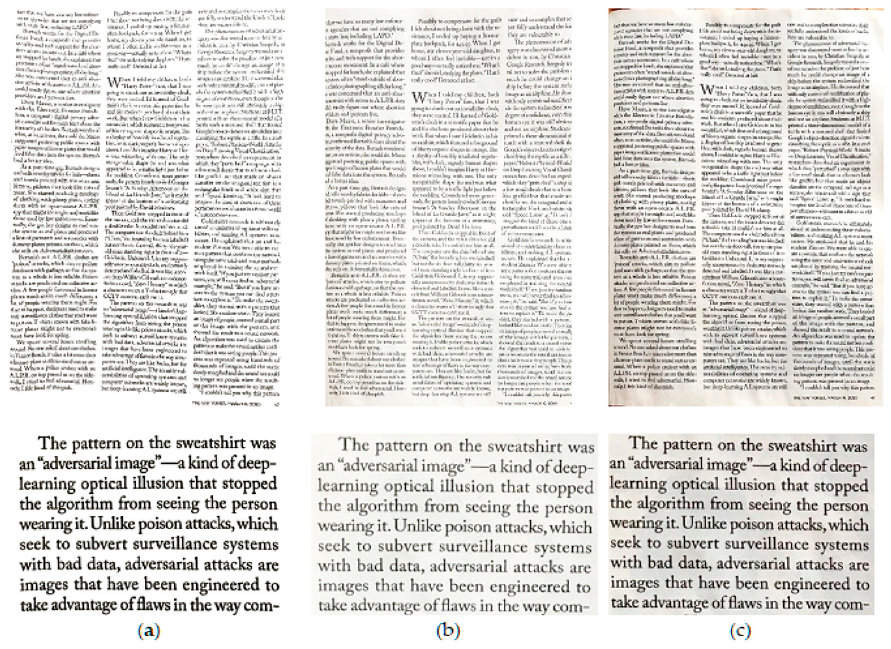
Figure 6. Sample results from a magazine page scan showing a zoomed paragraph. ( a ) CleanPage; ( b ) Google PhotoScan; ( c ) Microsoft Office Lens.